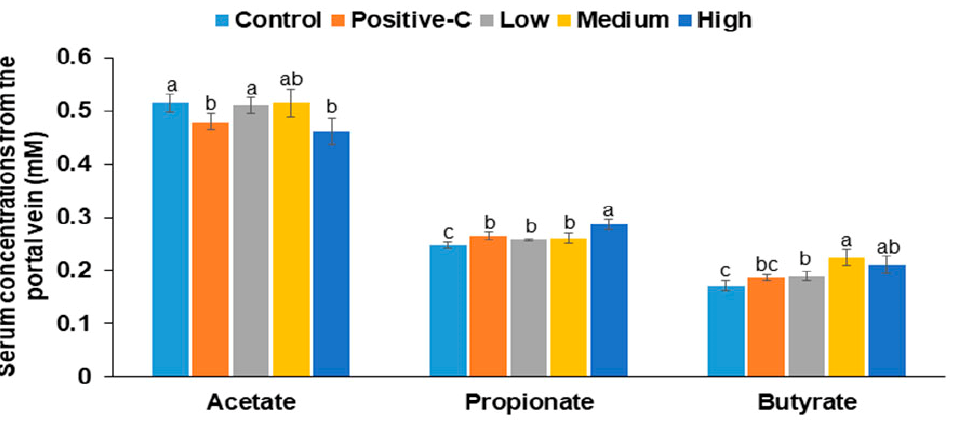
Figure 5. Serum short-chain fatty acid concentrations from the portal vein. Partially pancreatectomized (Px) rats were fed a high-fat diet supplemented with 0% (control), 0.2% (L-BC; low dosage), 0.6% (M-BC; medium dosage), and 1.8% (H-BC; high dosage) blackcurrant extracts; 0.2% metformin (positive-C); plus 1.8%, 1.6%, 1.2%, 0%, and 1.6% indigestible dextrin. At the end of the experiment, blood was collected from the portal vein, and serum was separated. Acetate, propionate, and butyrate concentrations were measured by gas chromatography. Each bar and error bar represents a mean and standard deviation, respectively ( n = 10). a,b,c Different letters on bars indicate significant differences among the groups at p < 0.05.